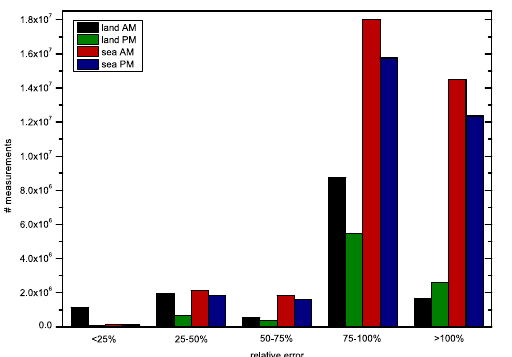
Fig. 7. Number of IASI NH 3 measurements with relative errors on the total column in the range 0–25, 25–50, 50–75, 75–100 and above 100% over five years (from 1 November 2007 to 31 October 2012).